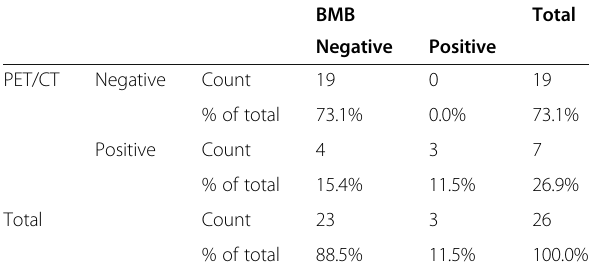
Table 11 Agreement between PET/CT and BMB in mixed cellularity cases